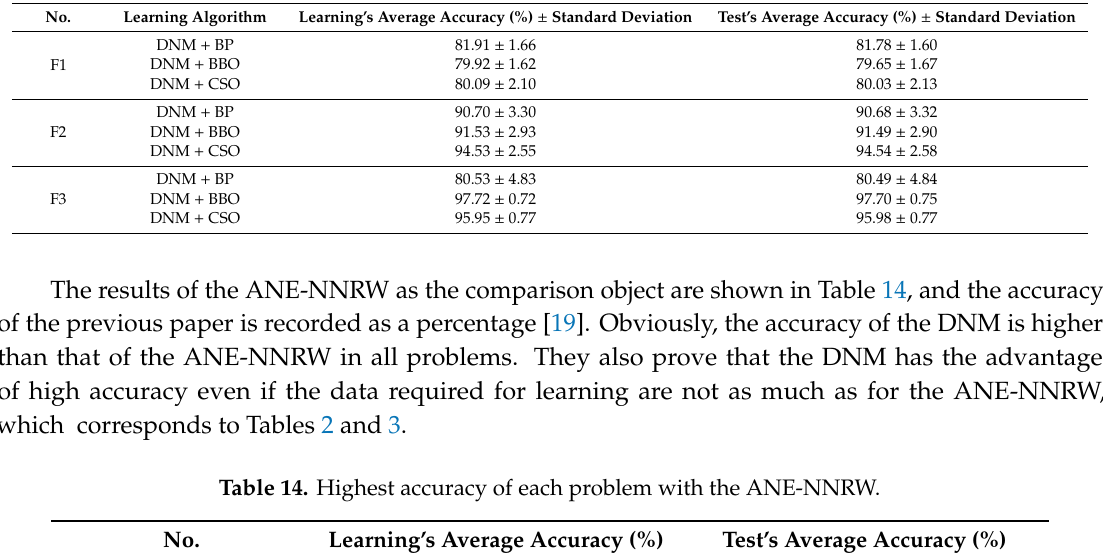
Table 13. Average accuracy and standard deviation of each learning algorithm.